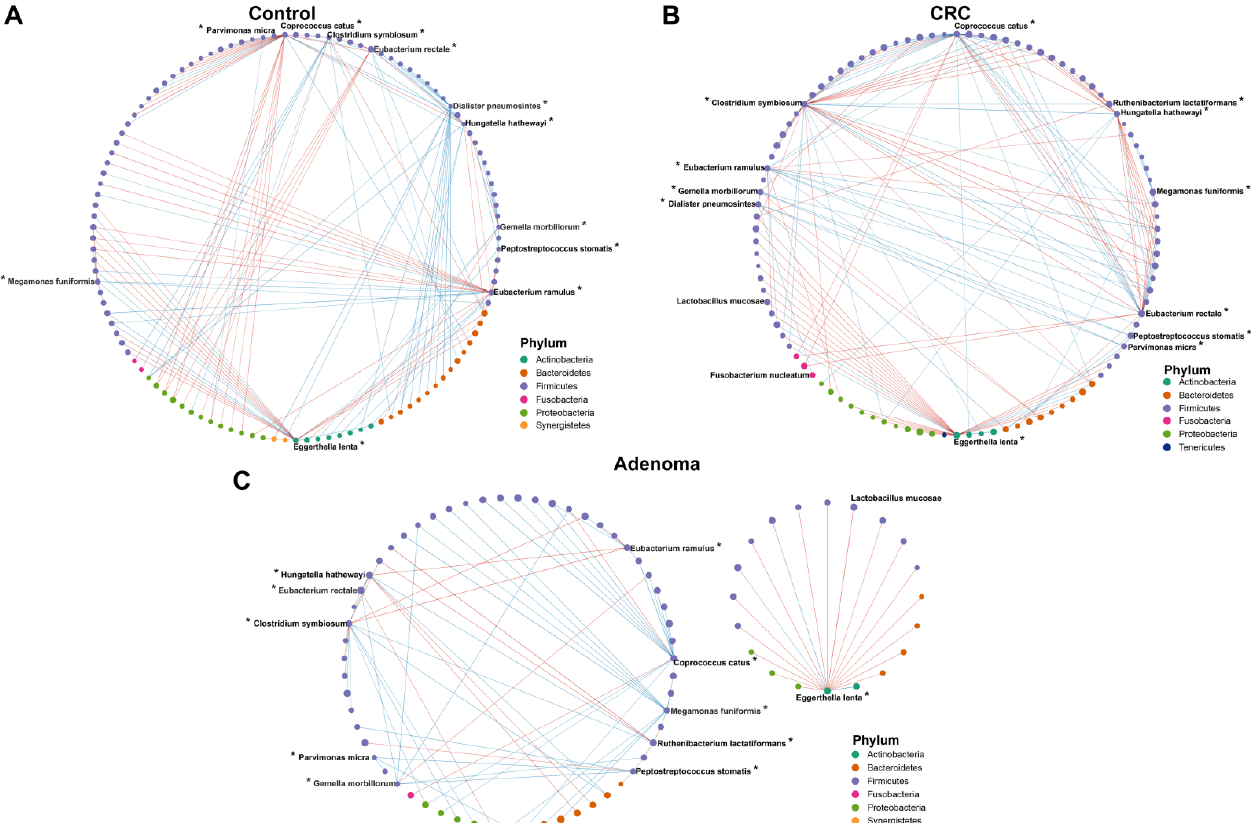
Figure 6. The correlation networks across the bacteria in the control ( A ), CRC ( B ), and CRA ( C ) groups. Lines between dots indicate the significant correlation of species ( p < 0.05). The blue line indicates a positive correlation, and the red line indicates the presence of a negative correlation. The size of the node is proportional to the relative abundance of species. The nodes are colored according to the phylum to which the species belongs. *, bacterial markers screened by the ran- dom forest model.